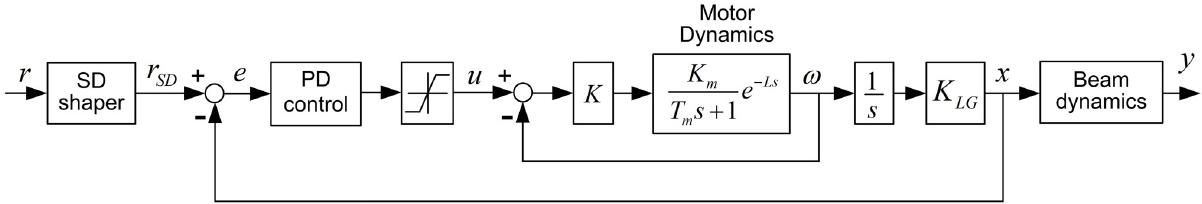
Fig 10. Block diagram of the horizontal beam vibration apparatus. The system includes a PD controller, motor dynamics, and beam